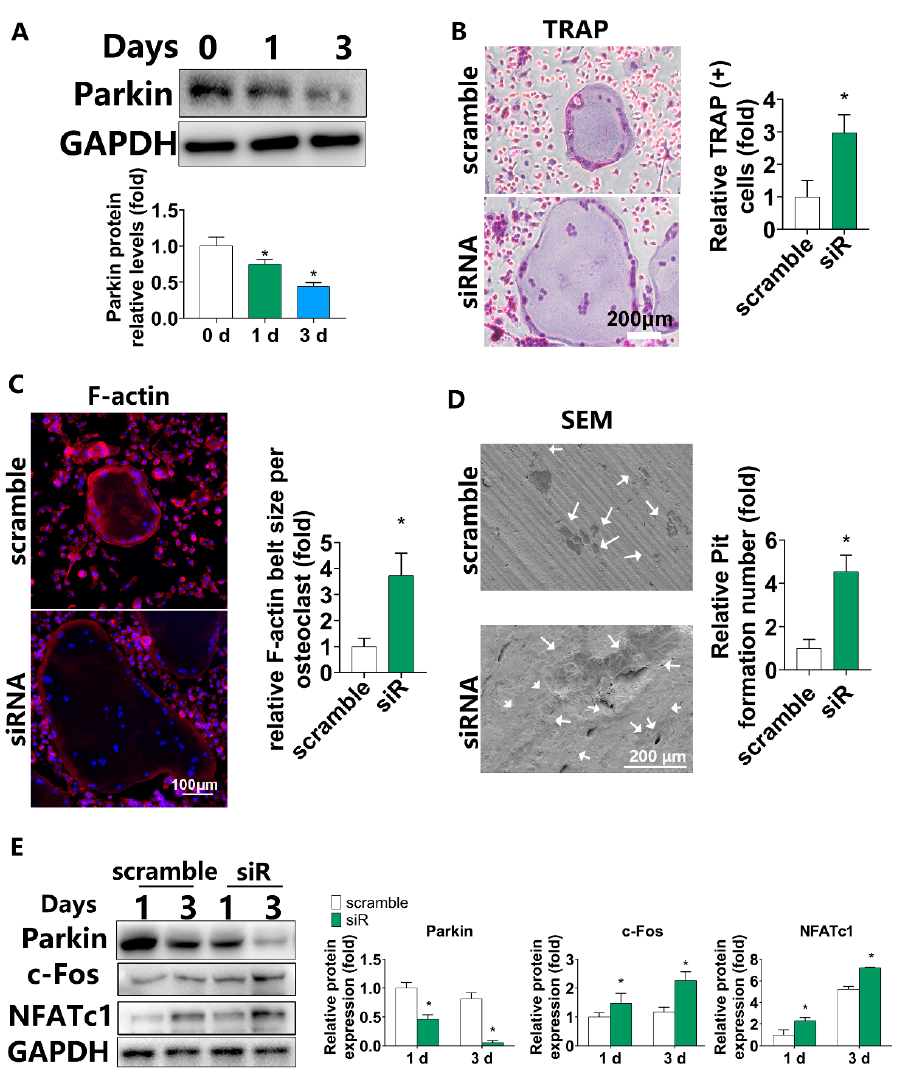
Figure 1. Parkin expression gradually decreases during osteoclastic differentiation and Parkin depletion enhances osteoclast differentiation in BMM. ( A ) Western blots showing the expression of Parkin at days 0, 1, and 3 days after osteoclastic induction. ( B ) One day after siRNA transfection, the cells were treated with RANKL (100 ng/mL) and M-CSF (30 ng/mL) for 5 days. The cells were fixed and stained for TRAP. “Scramble” represents BMMs transfected with control siRNA. “siRNA” represents BMMs transfected with Parkin-siRNA. Scale bars = 200 µ m. * p < 0.05 compared with scramble group. ( C ) One day after siRNA transfection, the cells were treated with RANKL (100 ng/mL) and M-CSF (30 ng/mL) for 5 days. The cells were fixed and stained with F-actin ring formation analysis. “Scramble” represents BMMs transfected with control siRNA. “siRNA” represents BMMs transfected with Parkin-siRNA. Scale bars = 100 μ m. * p < 0.05 compared with scramble group. ( D ) BMMs transfected with control or Parkin-siRNAs were induced with M-CSF and RANKL for 10 days. Representative SEM (scanning electron microscopy) images for bone resorption pits. “Scram- ble” represents BMMs transfected with control siRNA. “siRNA” represents BMMs transfected with Parkin-siRNA. White arrow represents pit formation. ( E ) Parkin, NFATc1, and c-Fos protein levels were analyzed by Western blot analysis (1 and 3 days of osteoclastogenesis). “Scramble” represents BMMs transfected with control siRNA. “siR” represents BMMs transfected with Parkin-siRNA. * p < 0.05 compared with scramble group.